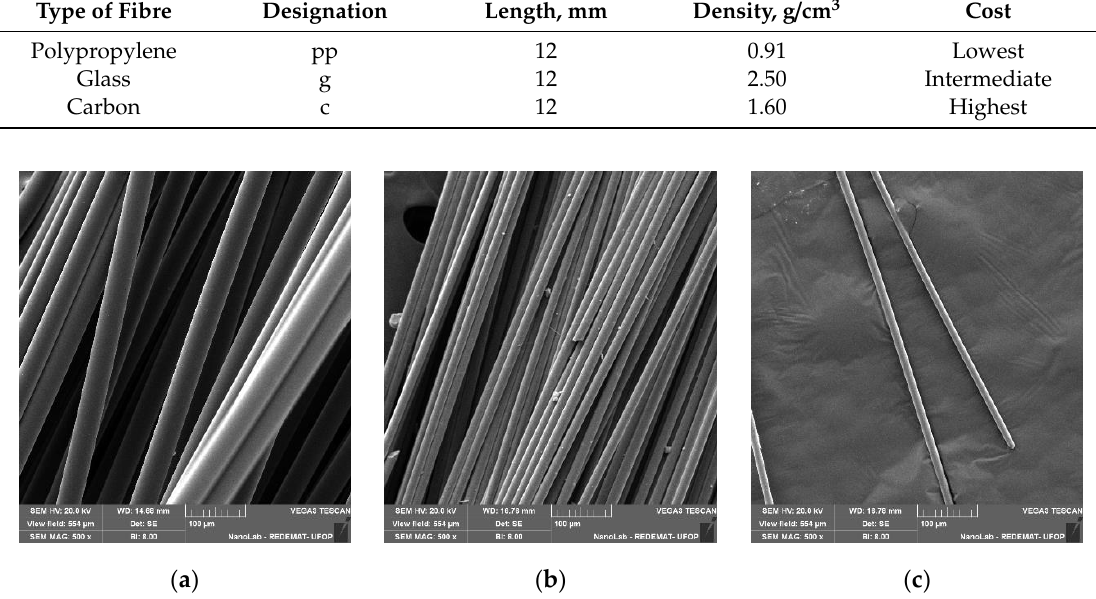
Figure 1. SEM images at 500× magnification of ( a ) polypropylene; ( b ) glass and ( c ) carbon fibres.